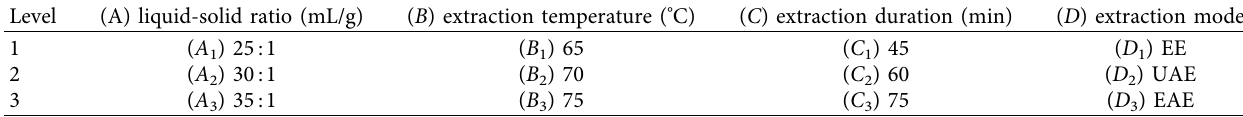
Table 1: Factors and levels of L